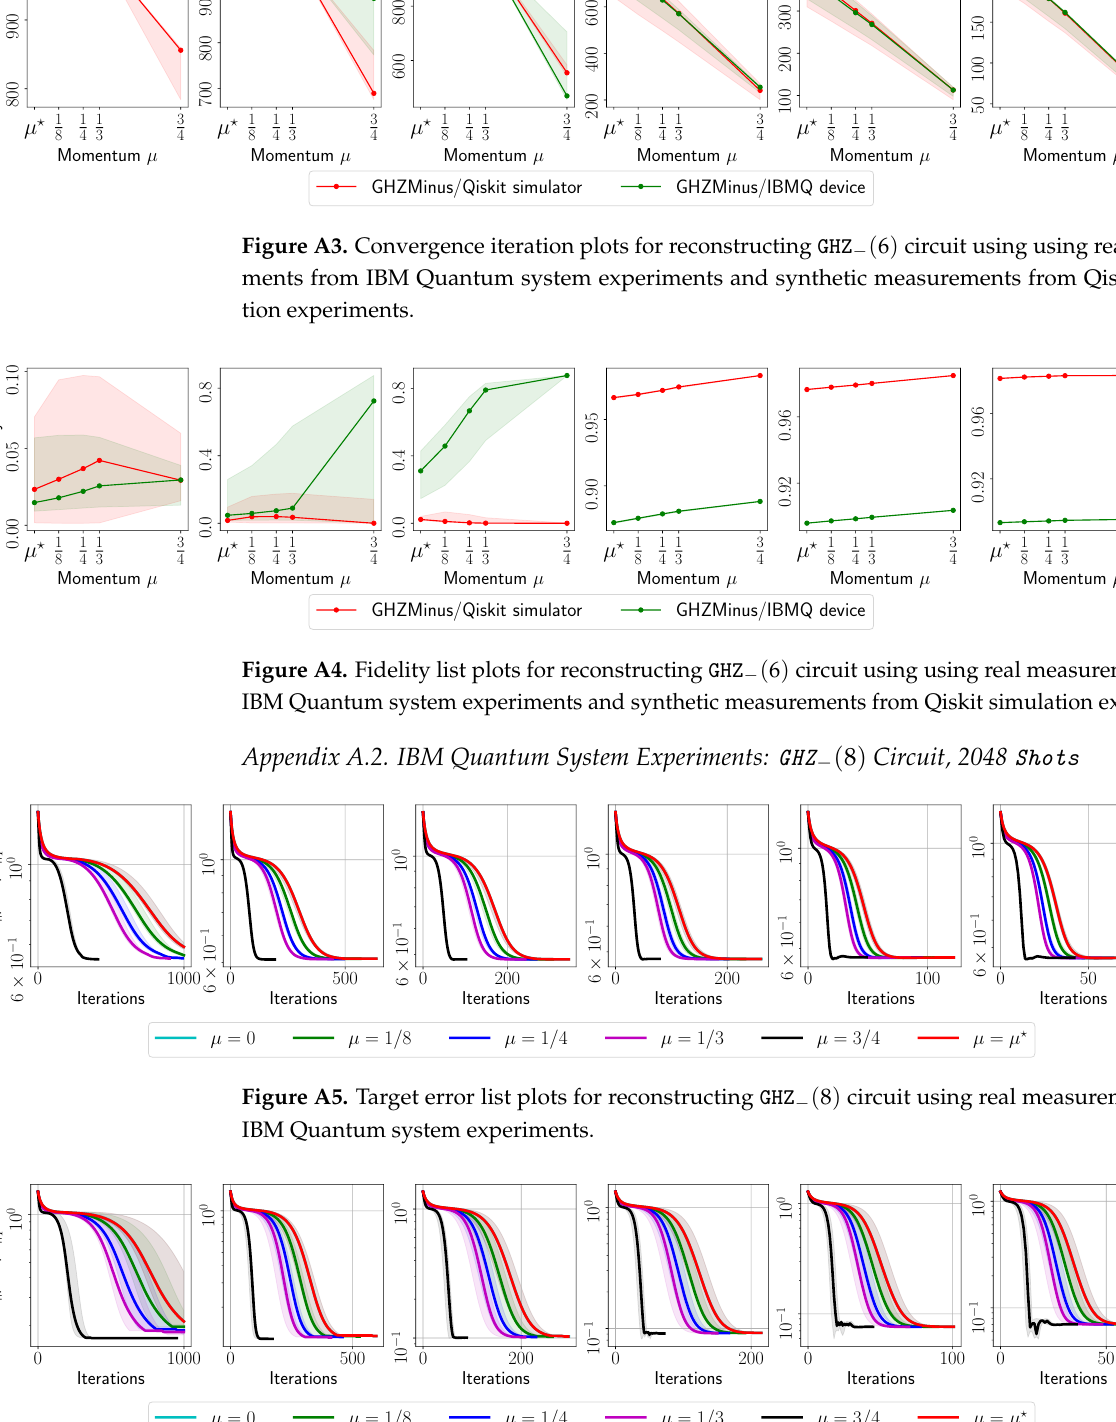
Figure A6. Target error list plots for reconstructing GHZ from IBM’s quantum